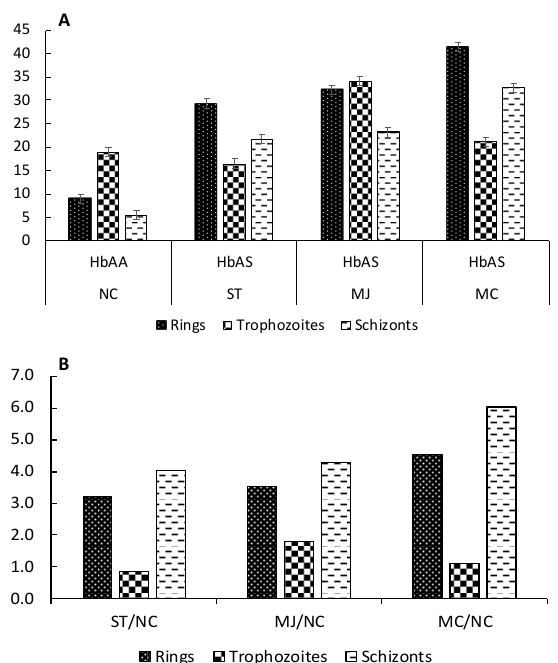
Figure 5. Intensities of P. falciparum proteins carbonylated bands across asexual stages. In panel A is shown individual intensity values for carbonylated bands by donors and erythrocytic stage; while in panel B is plotted the quotients HbAS/HbAA.